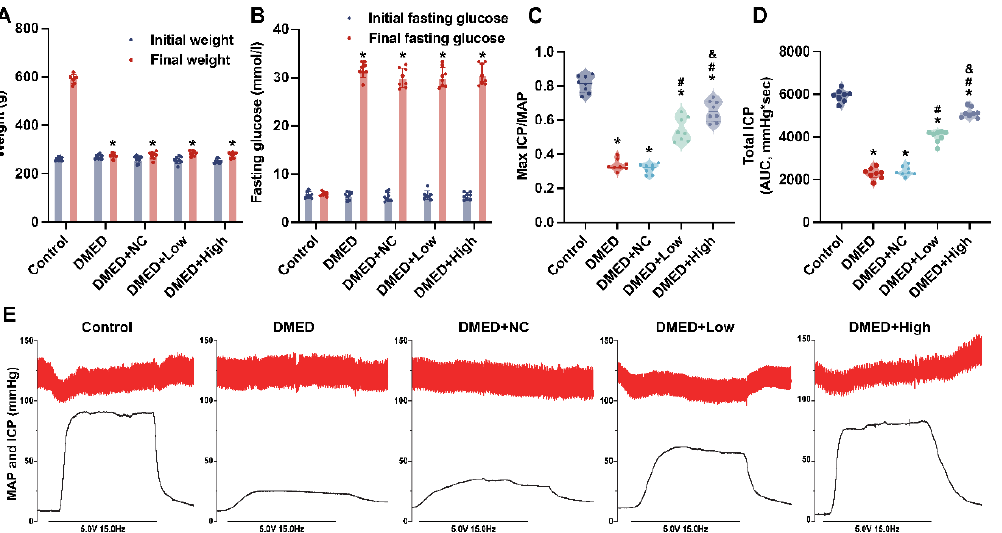
Figure 1. Assessment of metabolic indexes and erectile function in rats. ( A ) Initial and final weights for each group; ( B ) Initial and final fasting glucose levels for each group; ( C ) Total ICP and ( D ) the ratio of max ICP/MAP for each group; ( E ) Representative recordings of ICP and MAP during 1 min electrical stimulation at 5.0 V. * p < 0.05 compared with the control group. # p < 0.05 compared with the DMED group. & p < 0.05 compared with the DMED + low group.